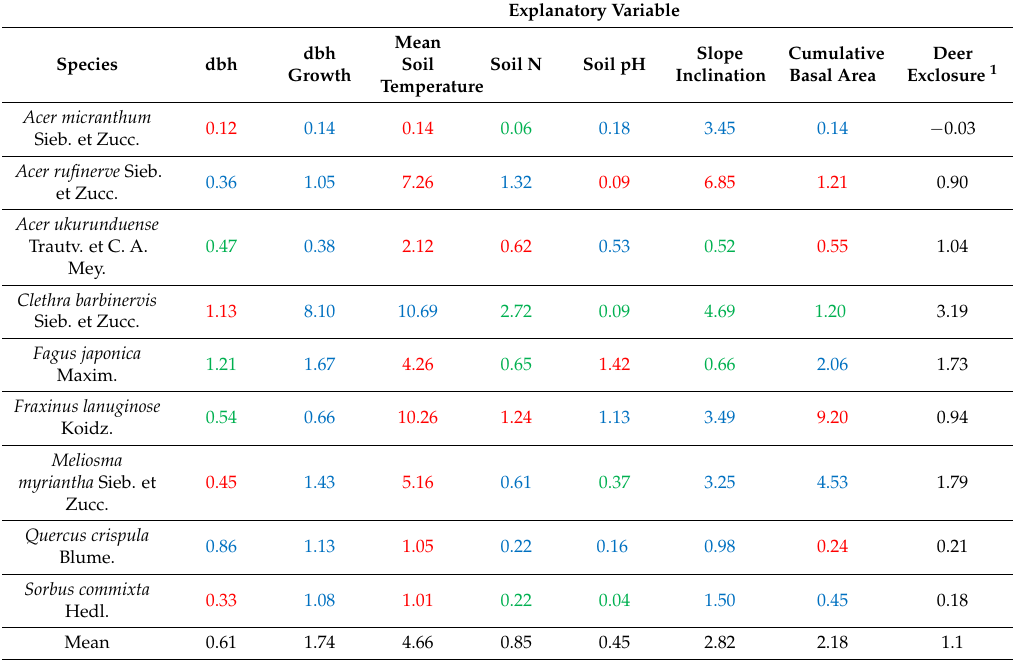
Table 1. Strength of response in expected resprout number to changes in explanatory variables. Red and blue font indicate that the expected resprout number exhibits an increasing or decreasing relationship with the focal explanatory variable, respectively. Green font indicates that the expected resprout number reaches a maximum or minimum at an intermediate value of the focal explanatory variable. See text for the detailed method of calculation. Explanatory